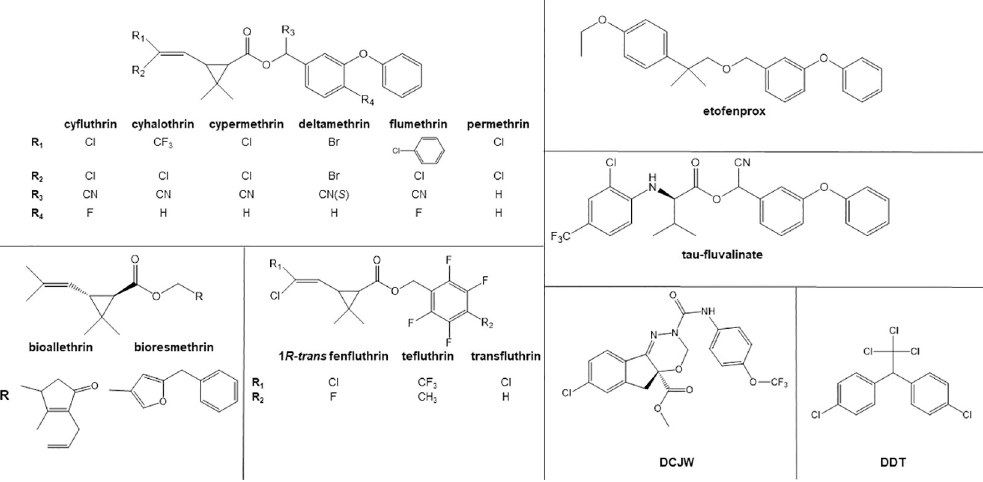
Fig 3. Structures of the insecticides tested. Stereochemistry is not indicated for all structures. All of the insecticides shown are pyrethroids, except for DDT and indoxacarb.